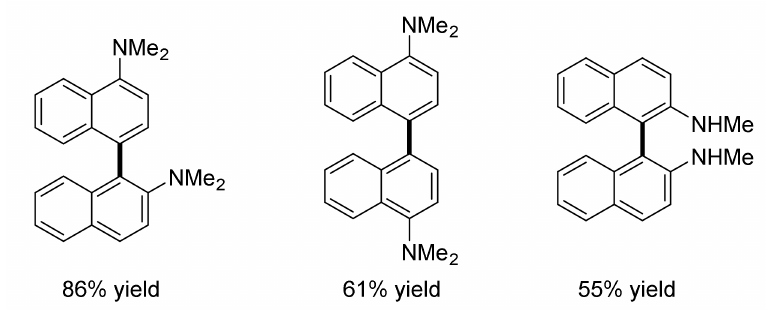
Figure 7. Naphthylamines